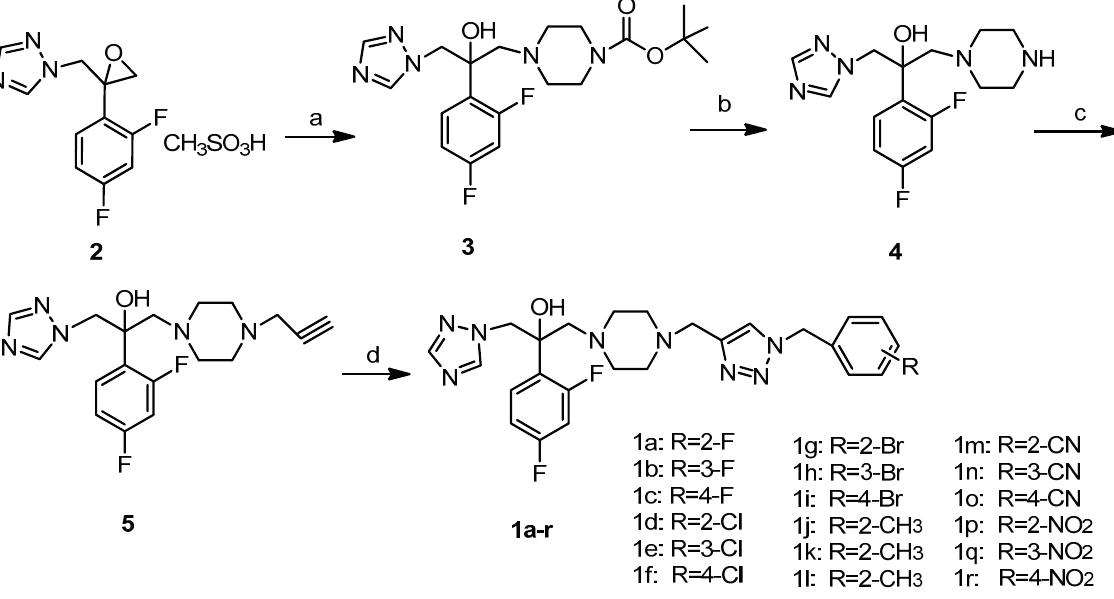
Table 1. Antifungal activities of the target compounds in vitro (MIC